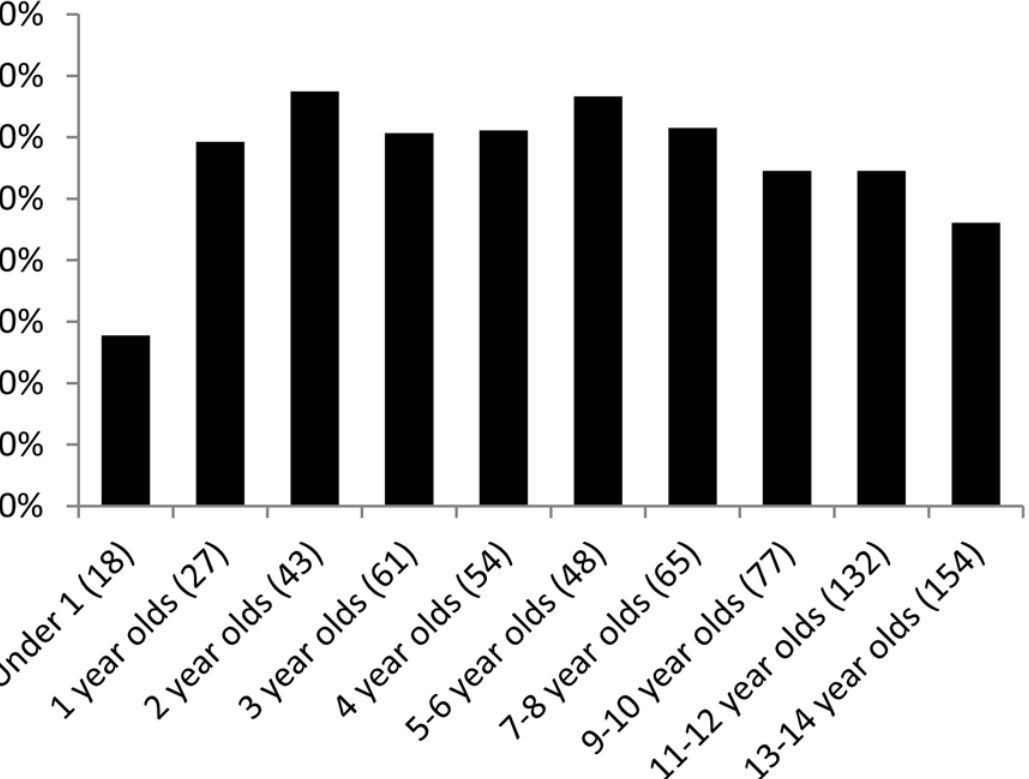
Fig 1. Proportion of children in each age group whose parents reported that they had been dewormed at least once during the previous year, Kibera, Kenya, 2012. Numbers in parentheses represent denominators for each age group.